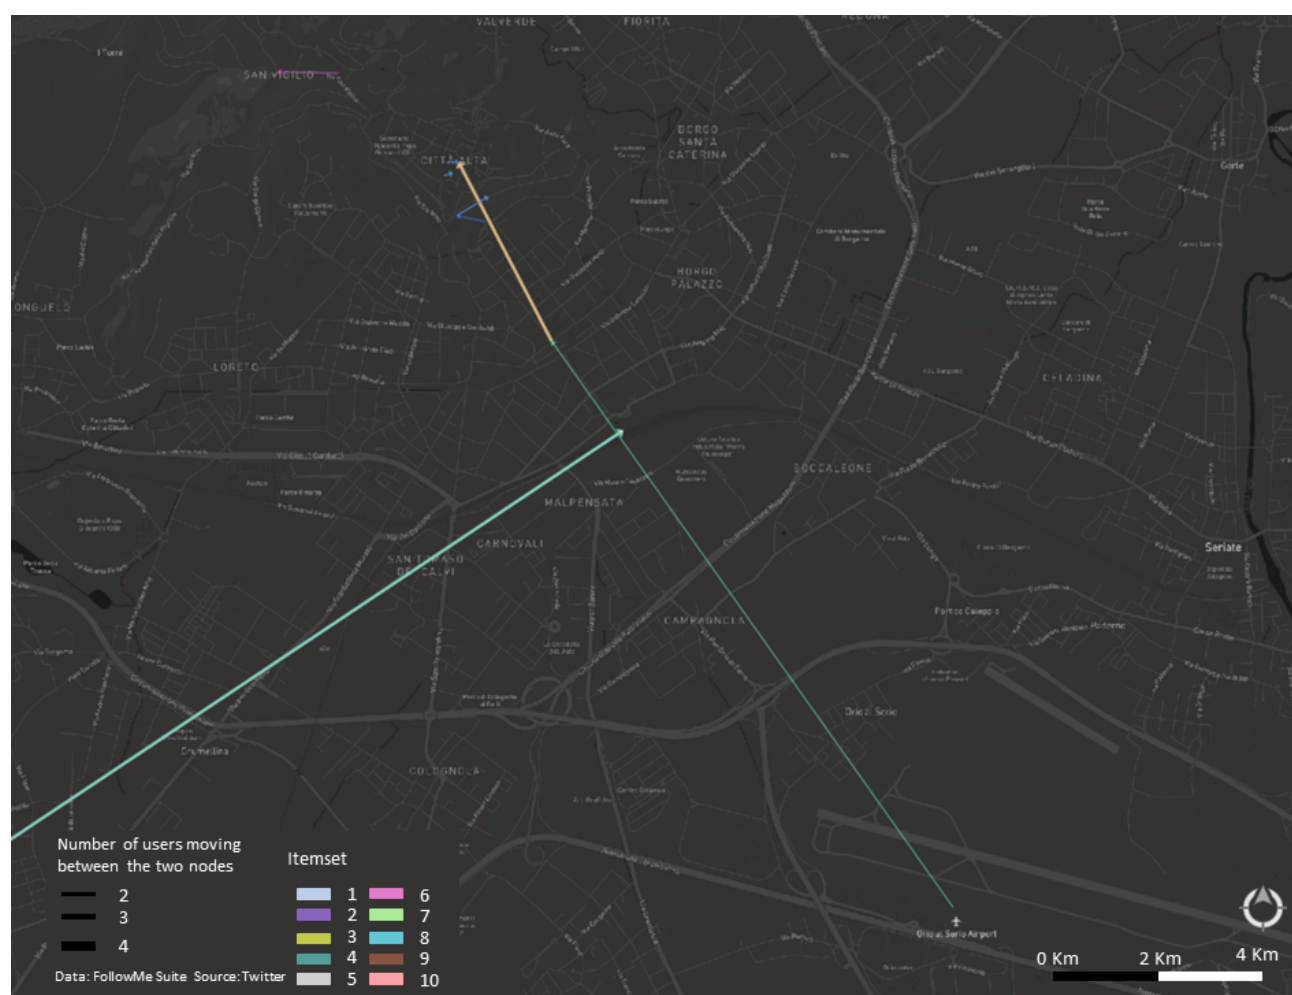
Figure 6. Topographic representation for discovered itemsets associating direct transfers, focused on Bergamo area.